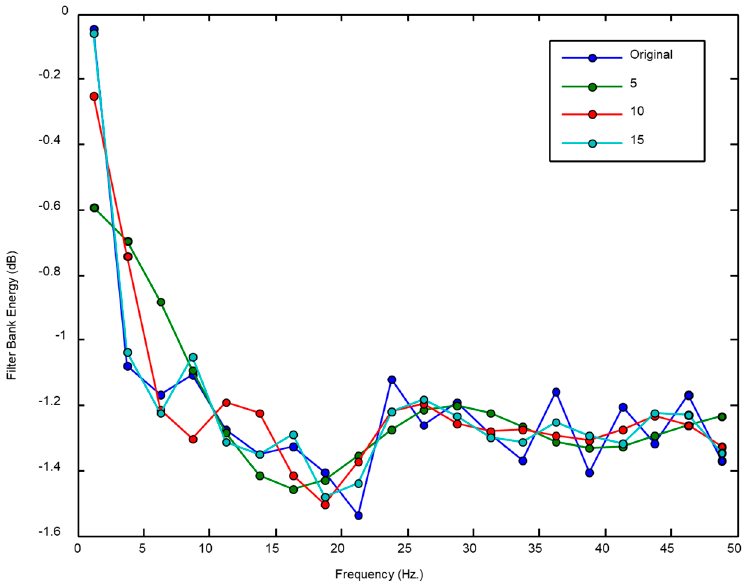
Figure 7. Impact on the spectrum of reducing the number of the cepstral coefficients.